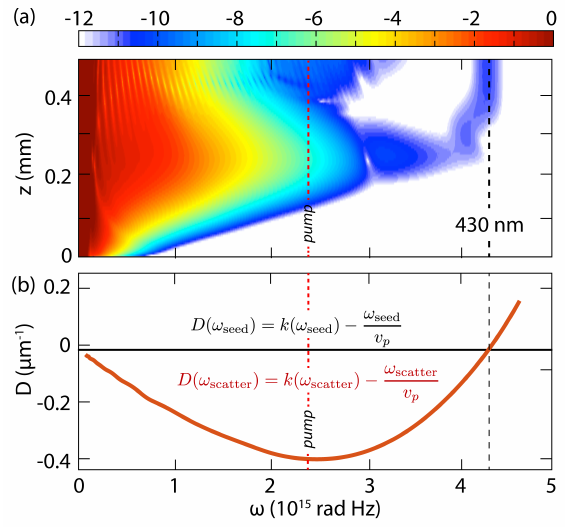
Figure 4. ( a ) Numerically simulated evolution of the seed field spectrum along the full 5 mm propagation distance based on Equation (4) (colormap is in logarithmic scale). ( b ) Dispersion, D ( ω scatter ) = k ( ω scatter ) − ω scatter / v p , for diamond calculated for the speed of the shock front, v p = ∼ 1.223 × 10 8 m/s (red curve). The horizontal line shows D ( ω seed ) = k ( ω seed ) − ω seed / v p : the intersections with D ( ω scatter ) gives the spectral location of the phase-insensitive scattering peak. The blue-shaded box shows the THz input spectrum at 1/ e 2 . For the sake of clarity, the spectral position of the 790 nm pump pulse is also shown with a vertical red dashed